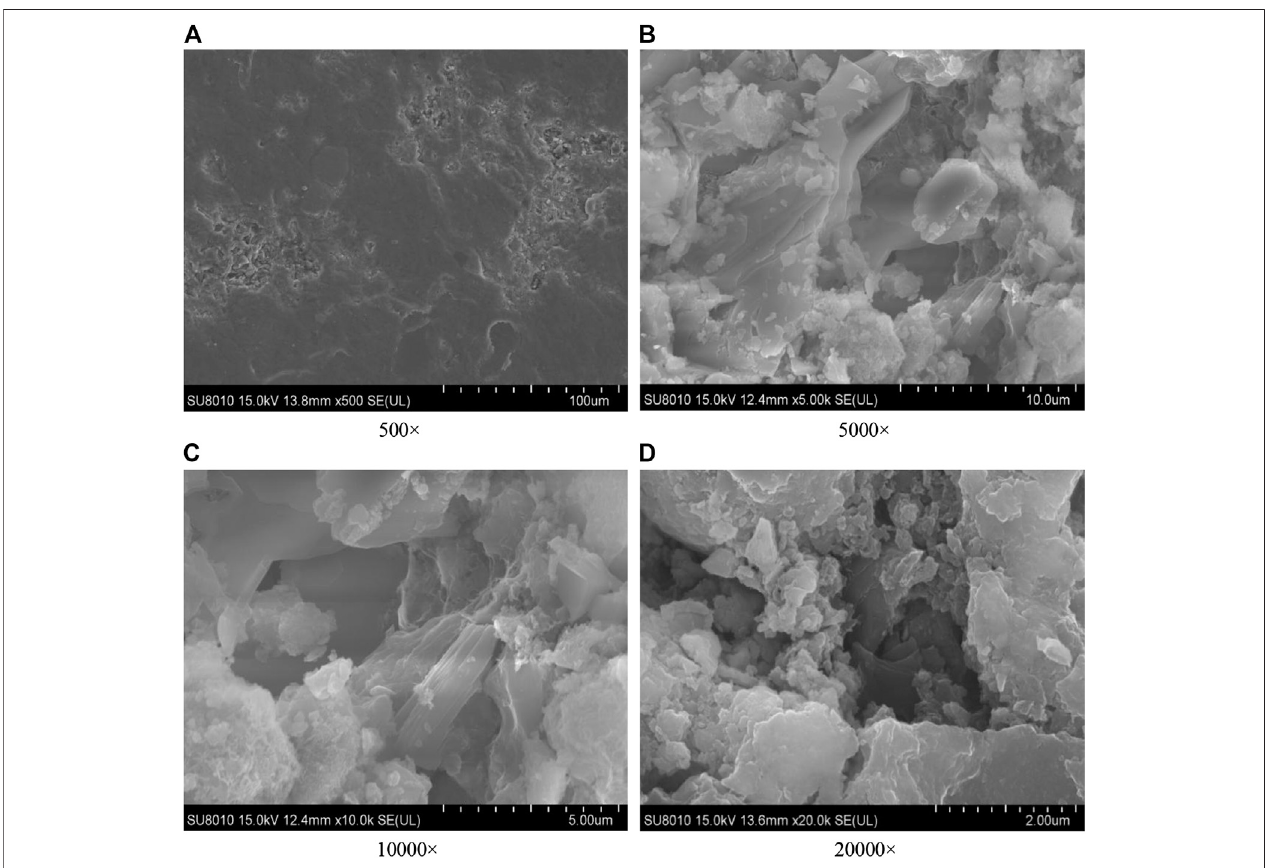
FIGURE 7 | SEM images of the geopolymer specimens of D2 group curing for 28 days.